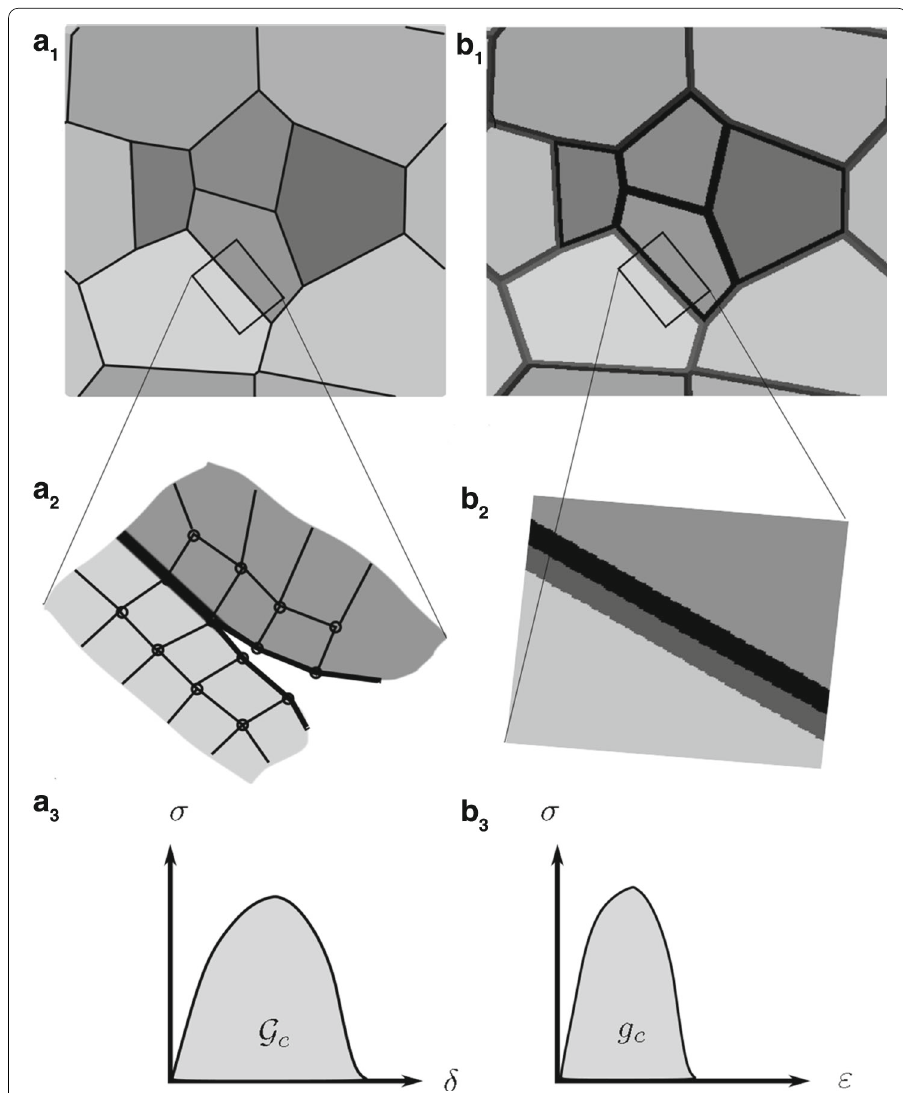
Fig. 1 Methodology for modelling a polycrystalline interface in finite element method ( a 1 – a 3 ) and FFT based solvers ( b 1 – b 3 ). a 1 shows a polycrystal with interface elements embedded at sharp boundaries. a 2 depicts an interface conformal finite element mesh with cohesive zones that open during loading according to the traction ( σ )—separation ( δ ) law shown in a 3 with characteristic fracture energy G c . b 1 shows the same polycrystal with interfacial bands representing the sharp interfaces. An example constitutive behaviour for